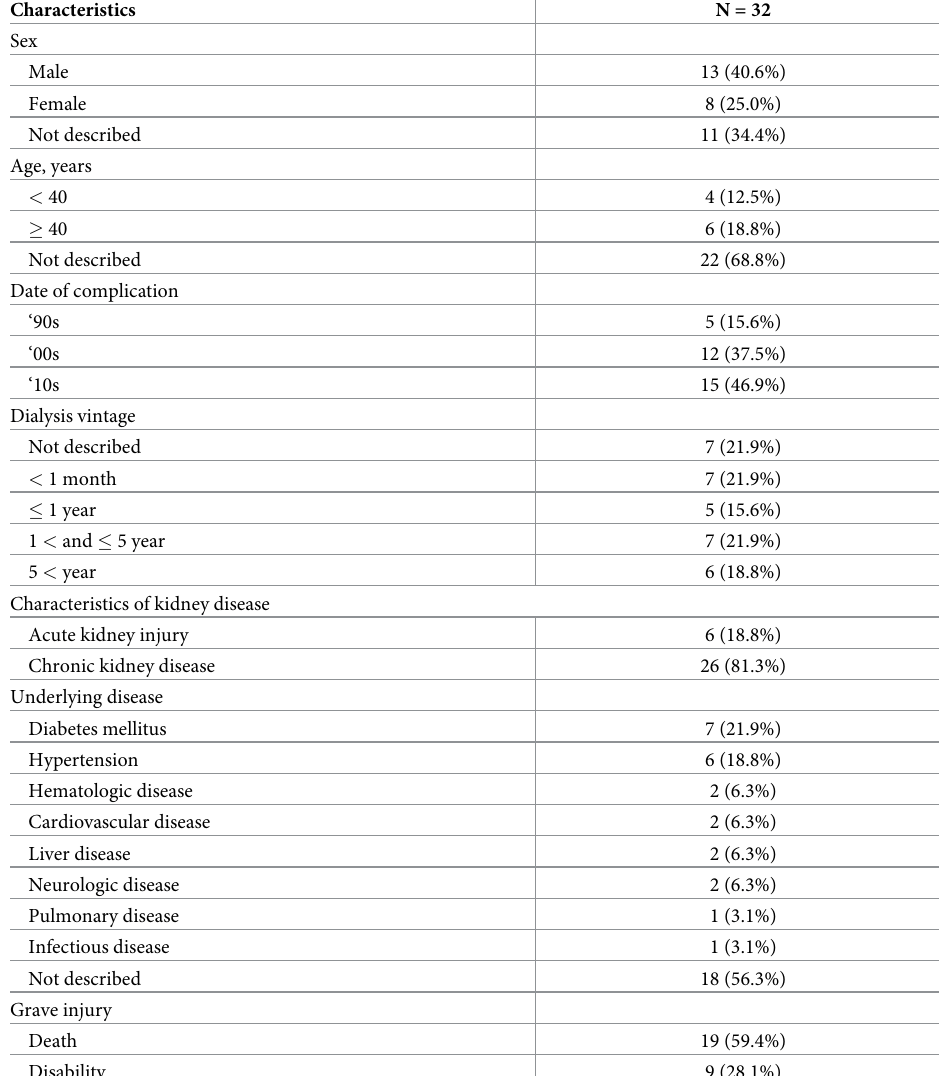
Table 1. Clinical characteristics of the litigation